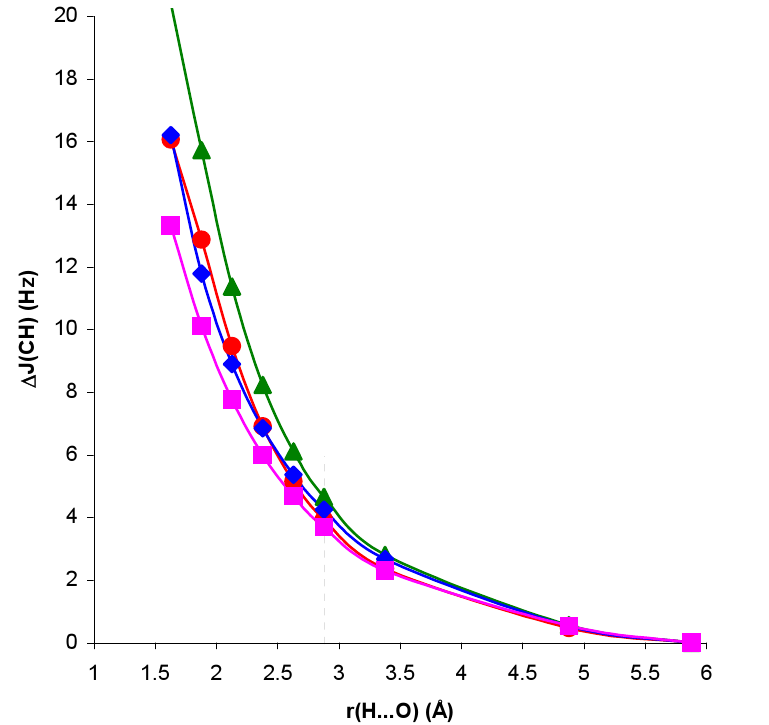
...OH complex, ∆ J C , and in the presence of the H 4 2 molecule, as a function of the H...O distance, 4